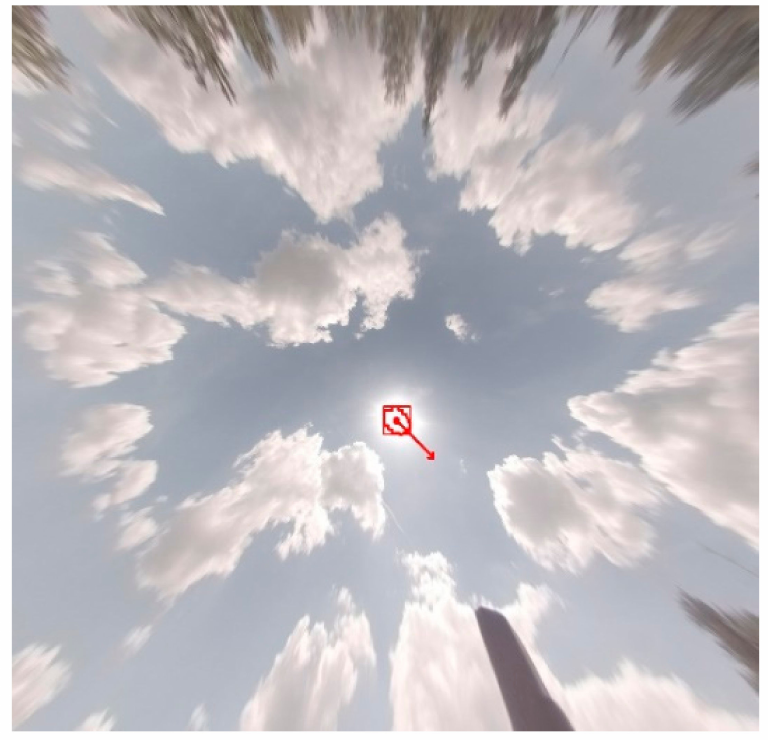
Figure 9. Change of the sun’s position within 1